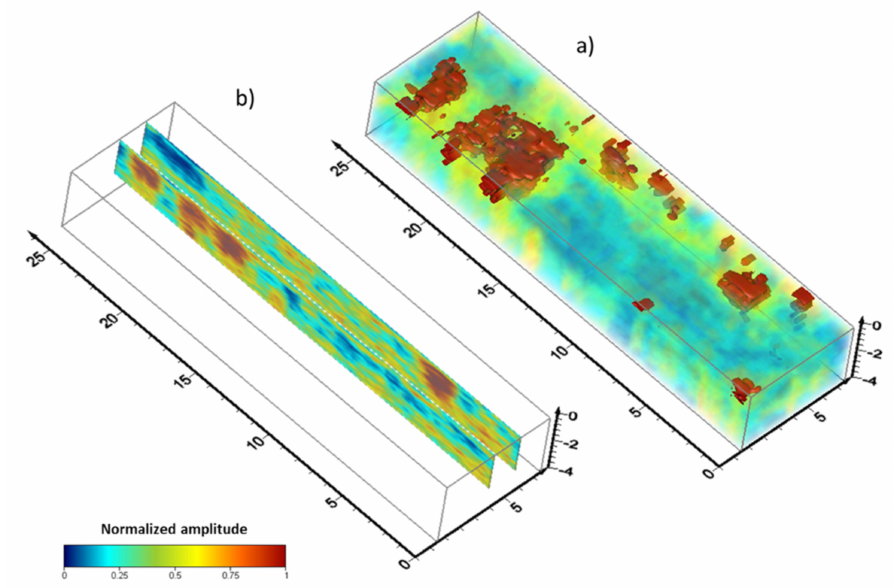
Figure 9. ( a ) Three-dimensional GPR model of the subsoil of the church showing the areas of major reflectivity, interpreted as due to the presence of burials or crypts; ( b ) vertical sections of the